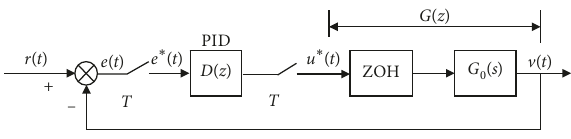
Figure 3: Diagram of digital